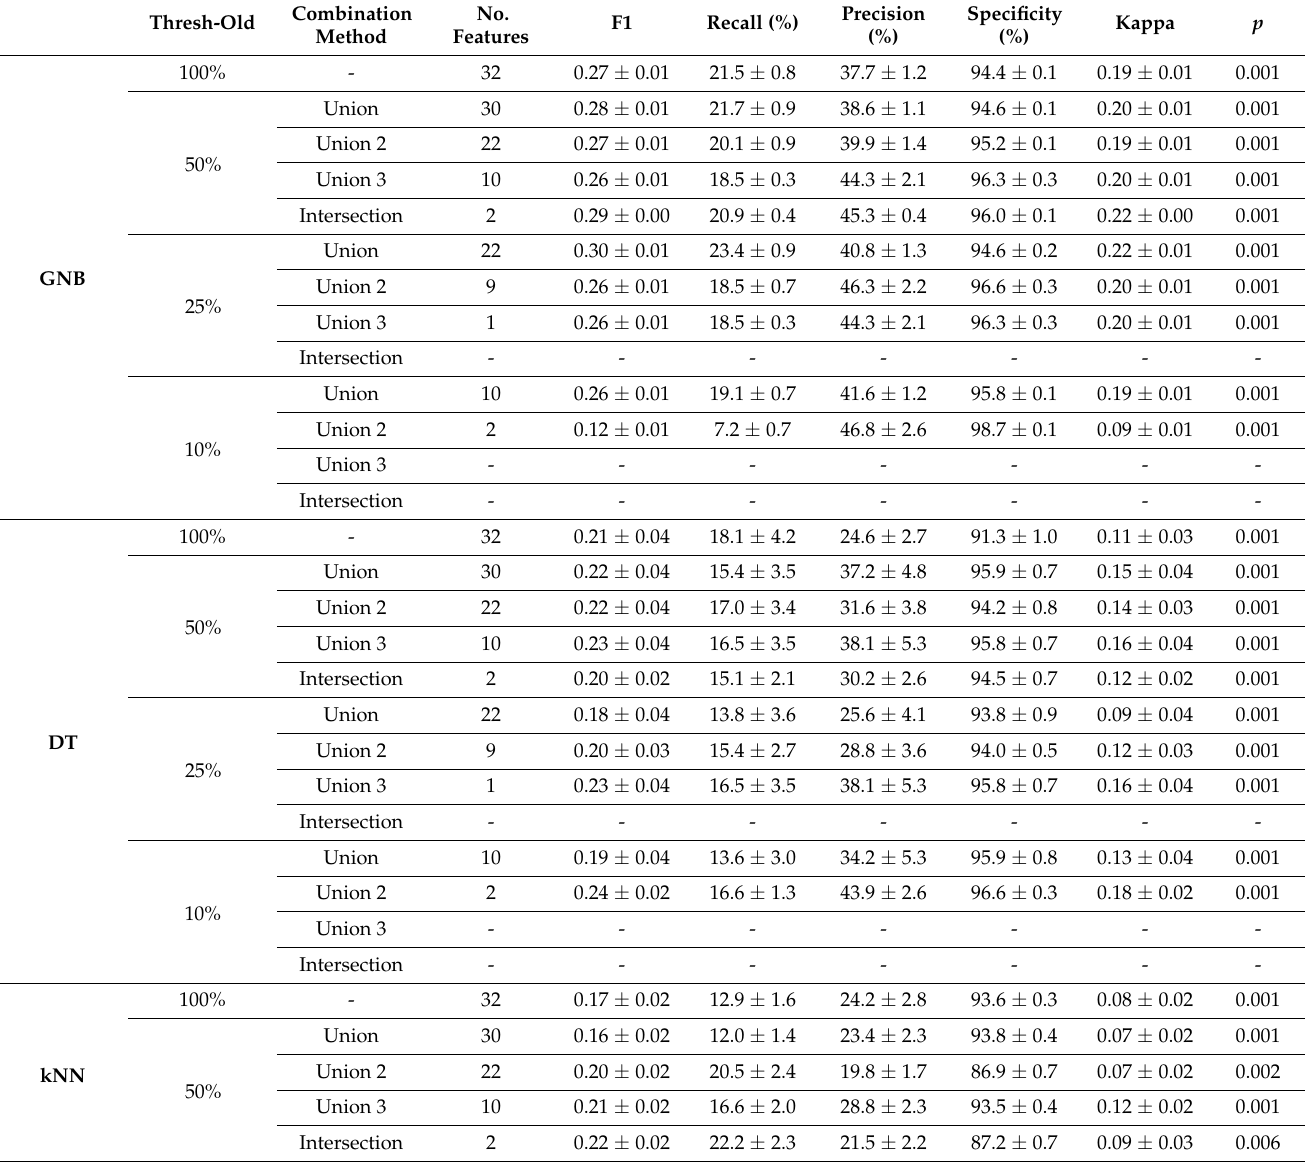
Table A10. Performance of the four classification models on detection fall using Mobility Lab Romberg stance with closed eyes ( data set ; Gaussian Naive Bayes (GNB); Decision Tree (DT); k-Nearest Neighbor (kNN); Support Vector Machine (SVM); p -value via permutation